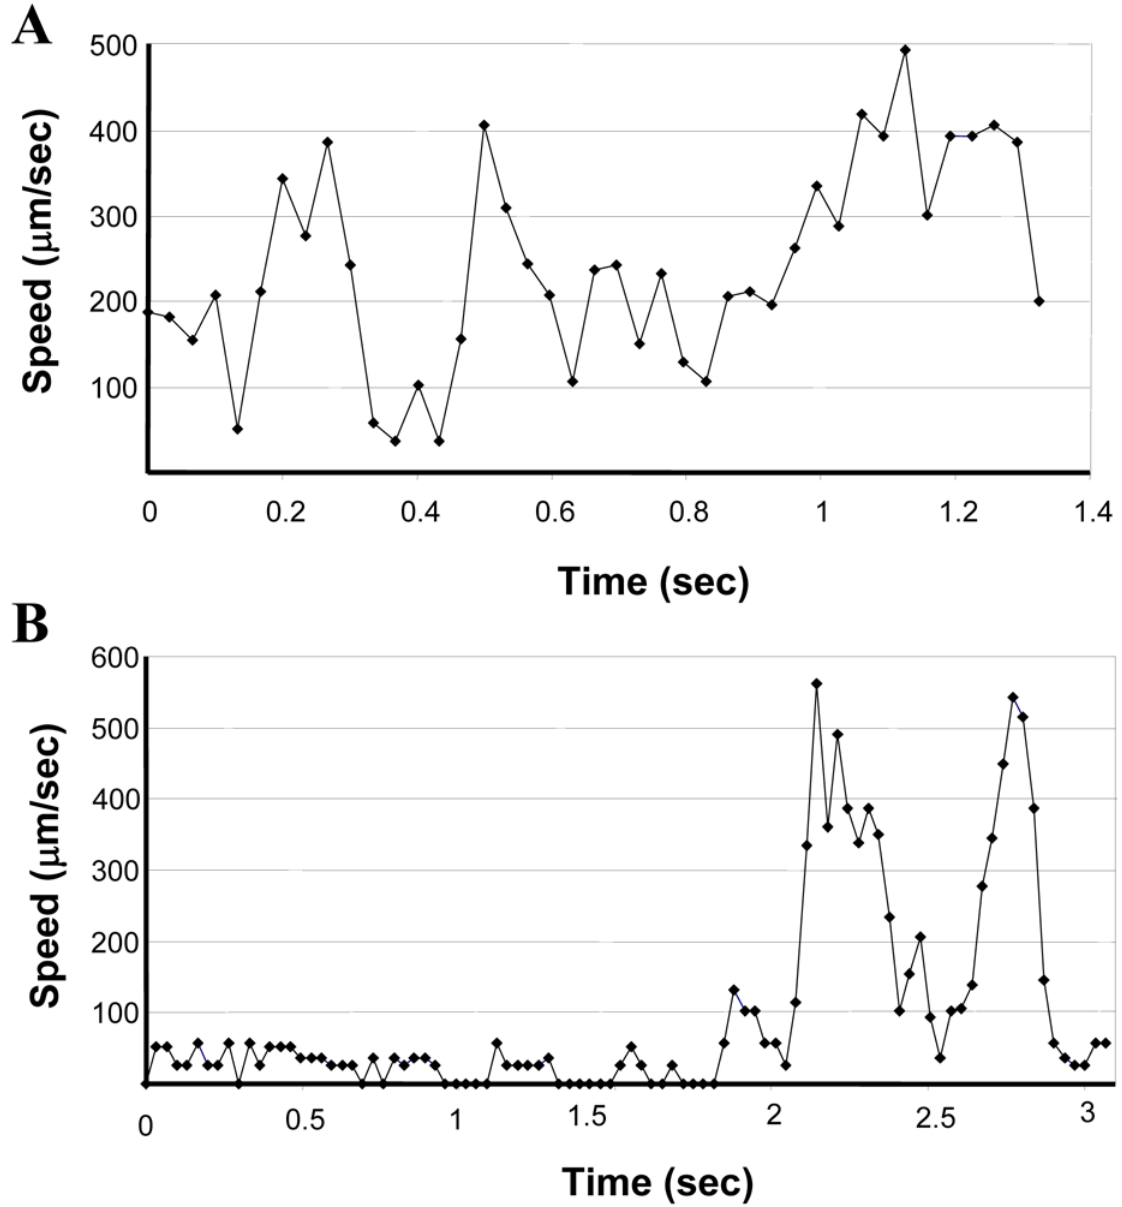
Figure 9. Instantaneous speeds of hASCs that slowly rolled on P-selectin. (A) A fast-rolling hASC exhibited characteristic stop-and-go behavior. (B) A slow-rolling hASC exhibited characteristic stop-and-go behavior. Both representative profiles are of hASCs rolling on P-selectin at a wall shear stress of 0.5 dynes/cm 2 . Non-rolling cells maintained relatively constant speeds (data not shown). Video is available for download on the Peirce-Cottler laboratory website